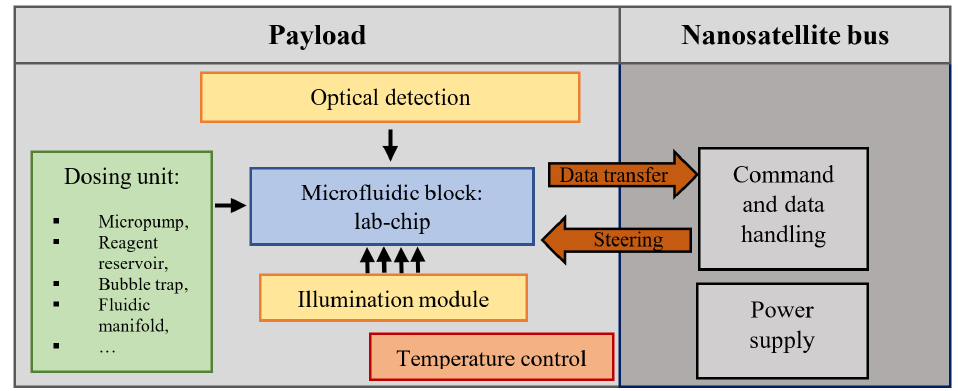
Figure 1. Overall schematic view of the payload for CubeSat type nanosatellite implementing biomedical experimentation.